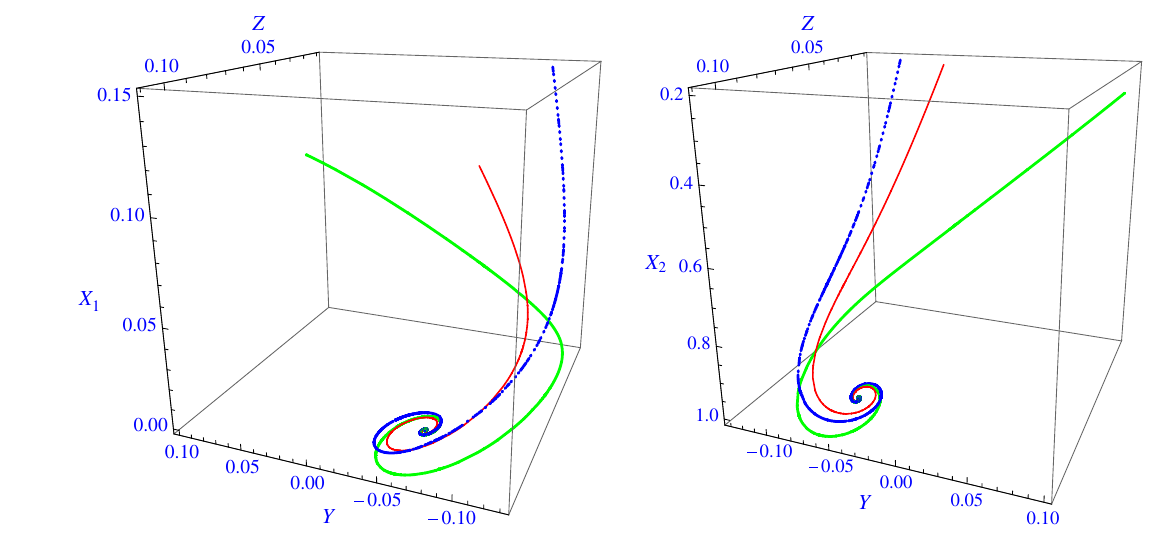
Fig. 1 Trajectories in the phase space of X 1 , Y , and Z (left figure) and X 2 , Y , and Z (right figure) with different initial conditions all converge to the anisotropic fixed point. The field parameters have been chosen as λ = 0 . 1 and ρ = 50. In addition, the initial conditions ( X 1 ( t =